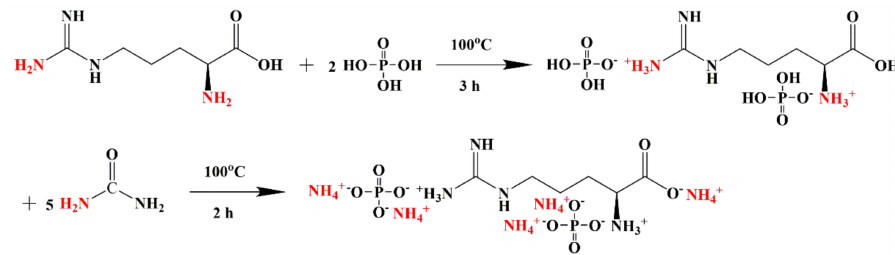
Figure 1. Synthesis principle of flame retardant.